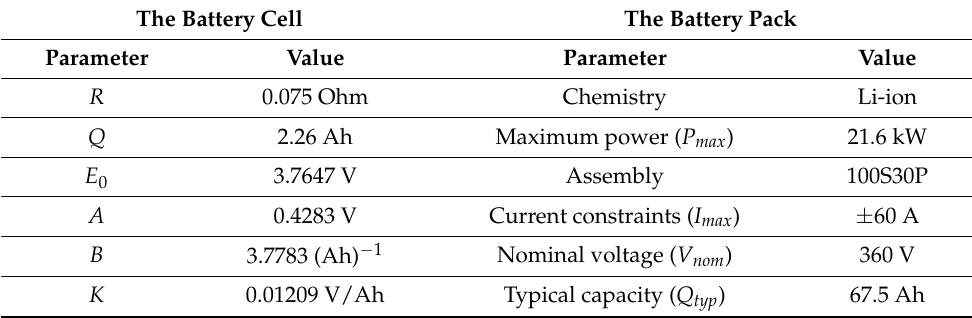
Table 4. The battery cell and the battery pack